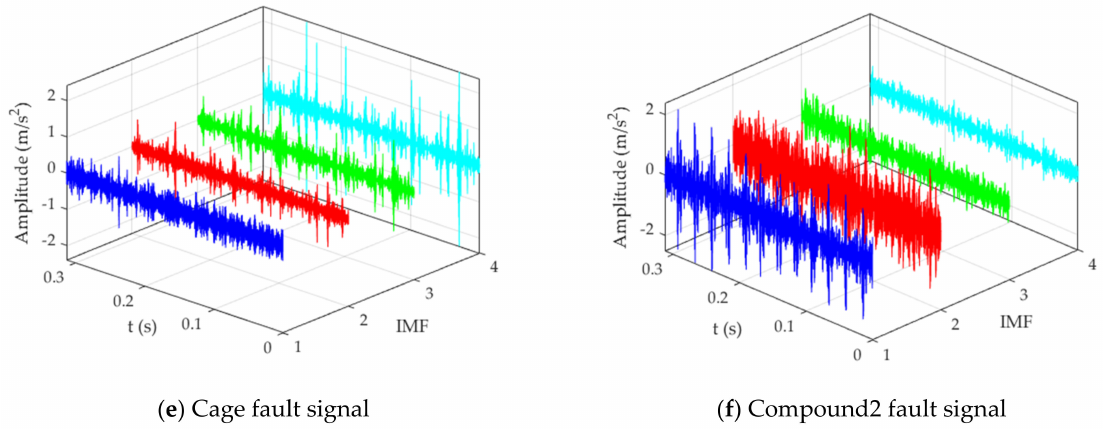
Figure 9. Time domain diagram of fault signal.